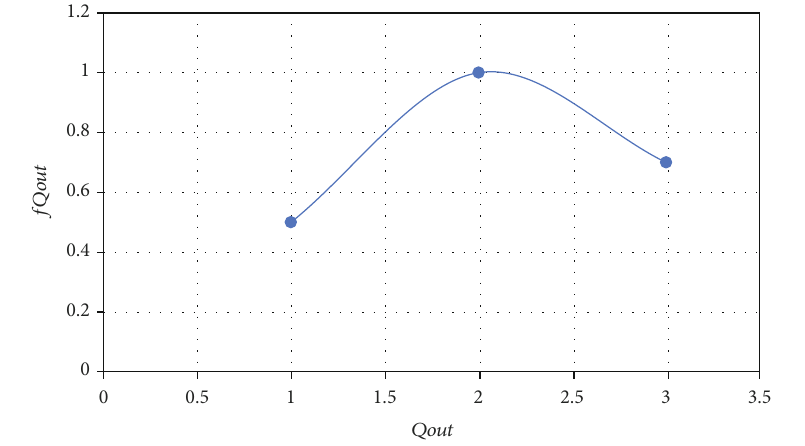
Figure 2: Turbine volume fl ow rate at